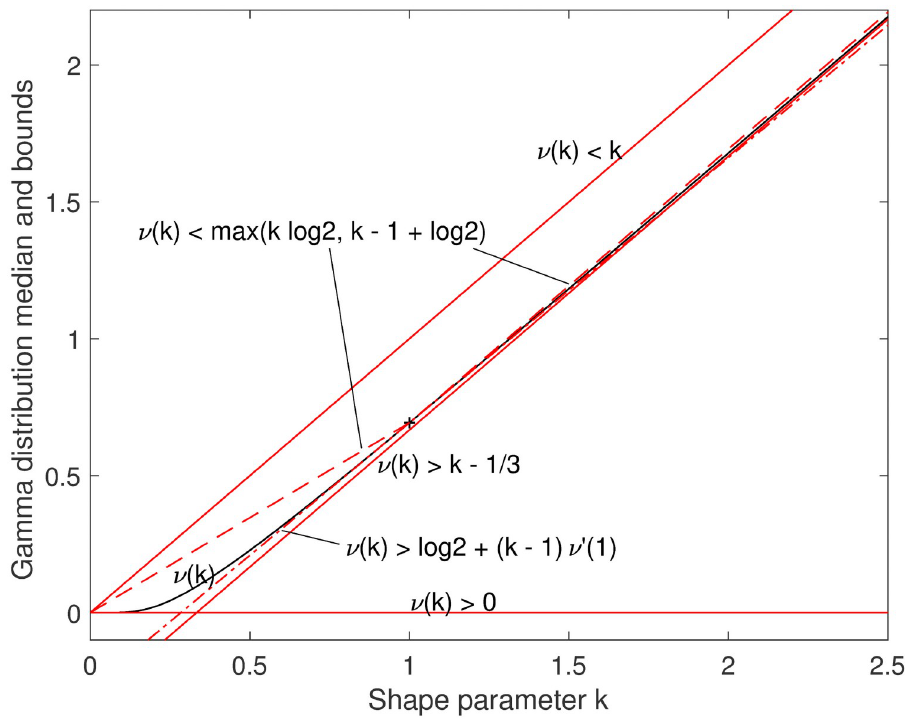
Fig 1. Linear and piecewise-linear bounds. The bounds k (cid:0) 1 < n ð k Þ < k and ν ( k ) > 0(solid lines) are shown along 3 with the true value (solid curve), the piecewise-linear bound that combines the recent linear bound for k > 1 [4] with a chord segment (dashed lines), and the linear lower bound that is tangent at k = 1 (dash-dot line). The region k < 1 is not very usefully